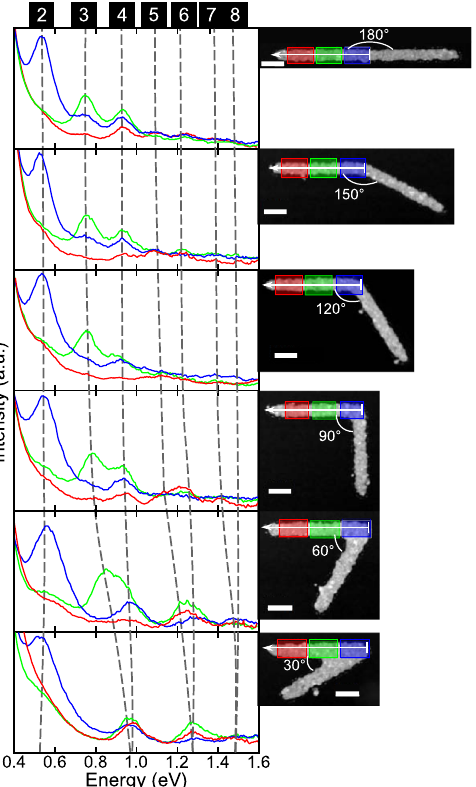
Figure 1: Evolution of NWs’ EEL spectra as a function of bending angle (left) acquired and averaged over three color-coded locations shown in the annular dark field (ADF) images (right). The scale bar in all ADF images is 100